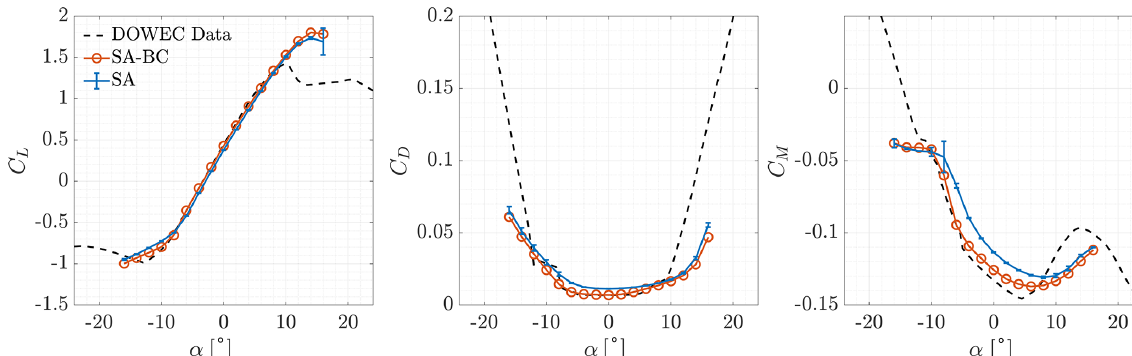
Figure 7. Aerodynamic coefficients of the DU25 airfoil.